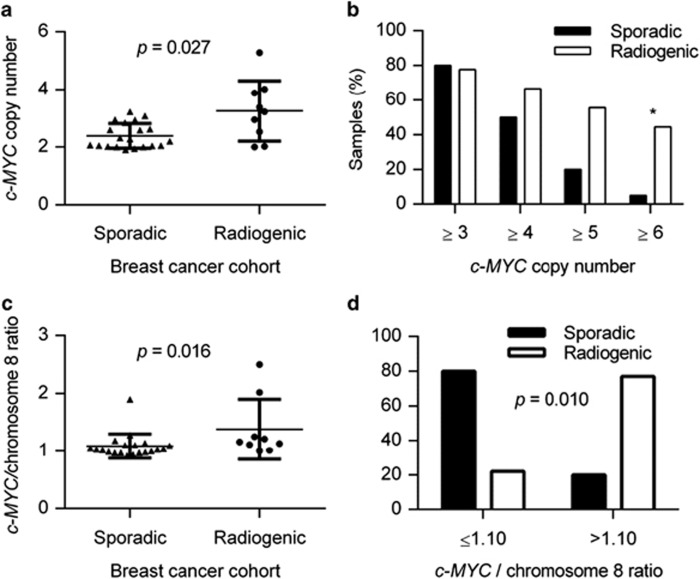
FISH analysis of c-MYC copy number and chromosome 8 copy number in sporadic and radiogenic breast cancers. c-MYC copy number was assessed in tumour cells from radiogenic cancers (n=9) and from sporadic cancers (n=20). c-MYC copy number was higher in the radiogenic cancers (Mann–Whitney U-test; P=0.027) (a). The wider horizontal bars represent the median c-MYC copy number and the narrower horizontal bars represent the 10th and 90th percentiles of the data. The percentage of samples in which at least 10% of the nuclei contained ⩾3, 4, 5 and 6 copies of c-MYC was compared (b) and was significantly higher in the radiogenic cohort than in the sporadic cohort for ⩾6 copies of c-MYC (Fisher's exact test; P=0.022 (*)). The ratio between c-MYC and chromosome 8 centromere copy number was higher in the radiogenic cohort than in the sporadic cohort (Mann–Whitney U-test; P=0.016) (c). The percentage of samples in each cohort, which had a c-MYC to chromosome 8 centromere ratio ⩽1.10 (no or little evidence of c-MYC amplification) or >1.10 (evidence of c-MYC amplification) was also compared (d) (Fisher's exact test; P=0.010).